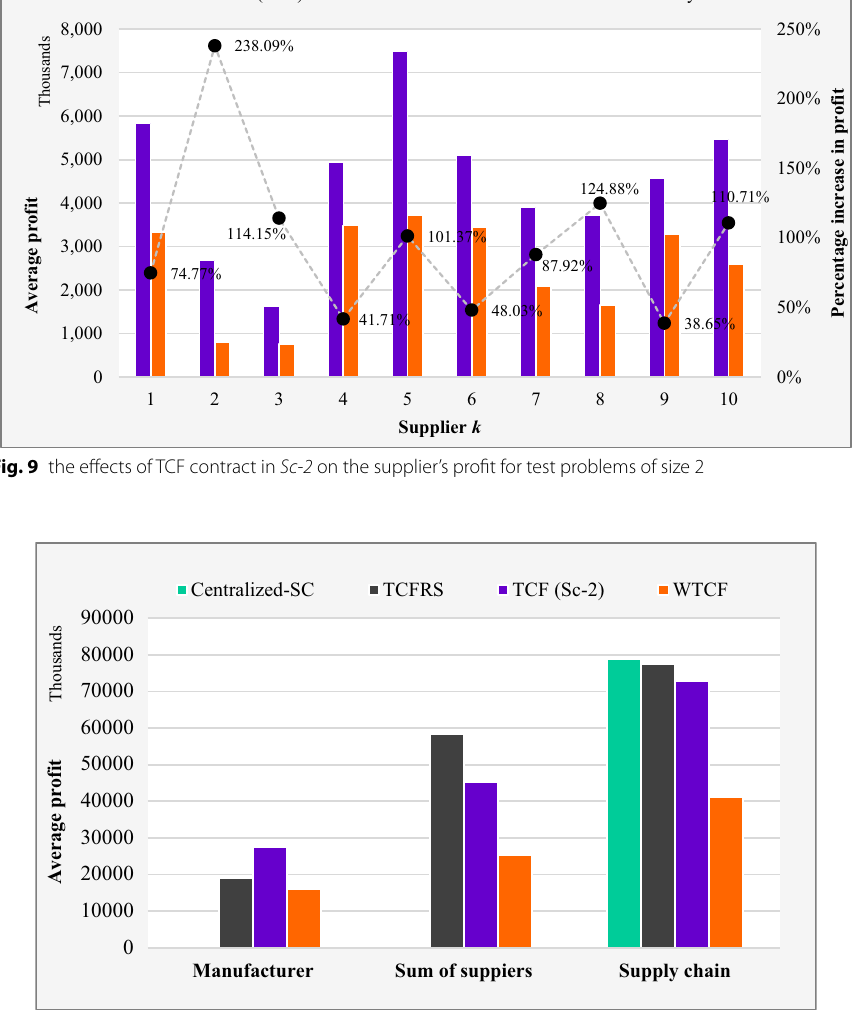
Fig. 10 A comparison between TCFRS contract, TCF contact in Sc-2 , WTCF case, and centralized structure for test problems of size